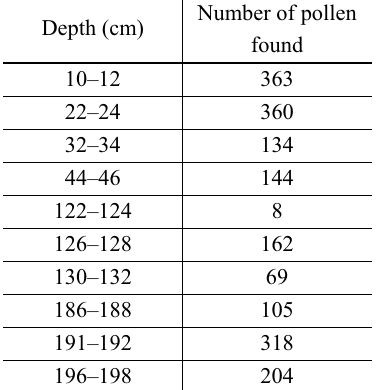
Studied intervals × number of pollen found. Number of pollen Depth (cm)